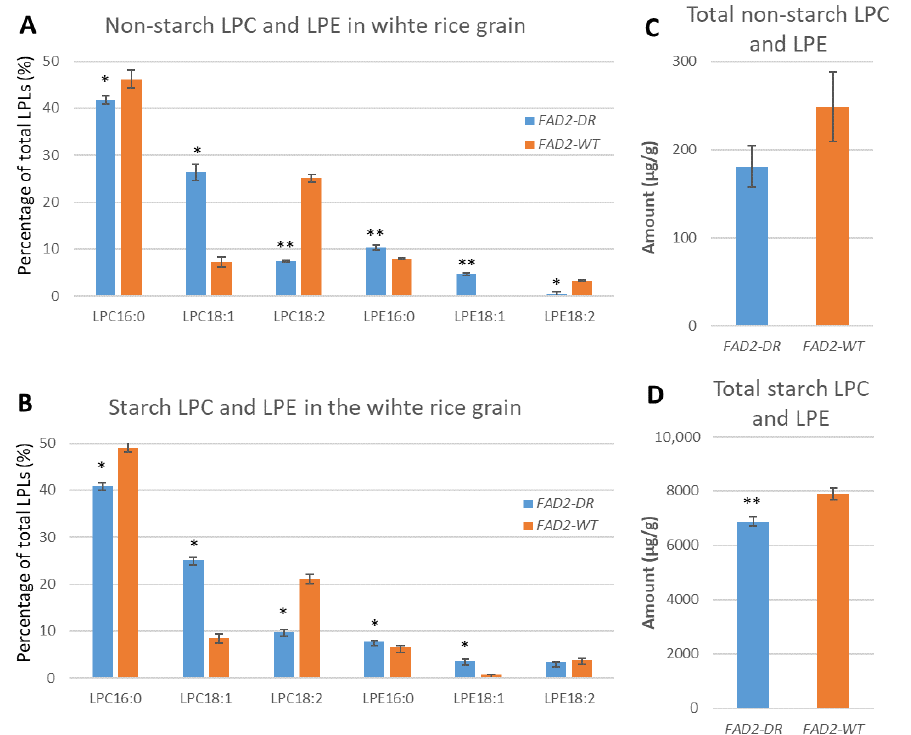
Figure 1. Fatty-acid composition of lysophospholipids in the white rice flour of FAD2-1 RNAi backcross lines. ( A , B ) Comparison of the fatty-acid composition of LPC and LPE in the non-starch and starch lipids between FAD2 DR and FAD2 WT ; ( C , D ) Comparison of total LPC and LPE in the non-starch and starch lipids between FAD2 DR and FAD2 WT flours. * and ** indicate the significance of difference at p <0.05 and p <0.01, respectively. Table 3. Rice grain starch thermal characteristics of FAD2 DR and FAD2 WT determined by DSC. Peak 1 Peak 2 Genotype 1 To ( ◦